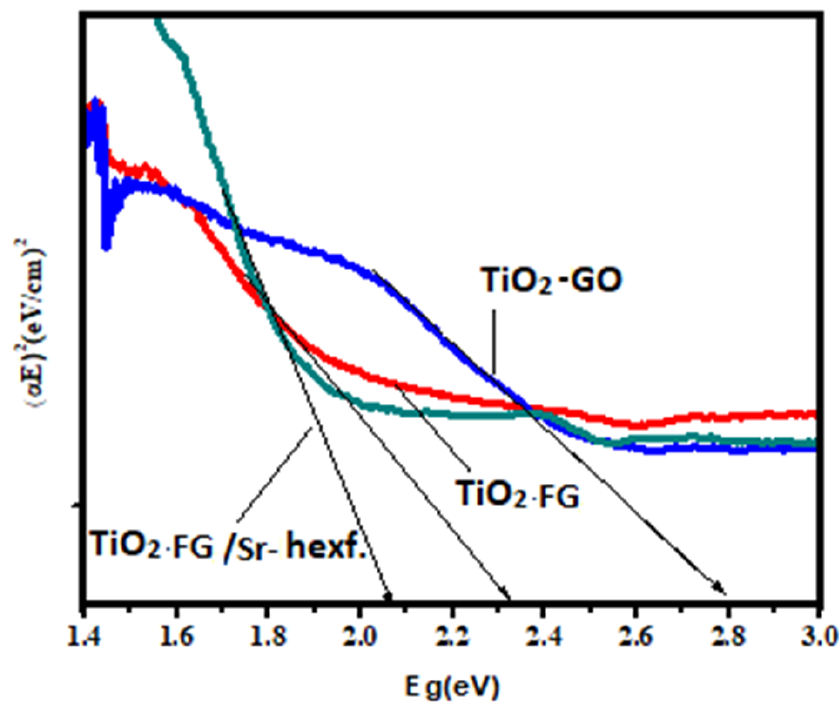
Figure 6. DRS spectra of TiO 2 ‐ GO, TiO 2 ‐ FG, and TiO 2 ‐ FG/Sr ‐ hexaferrites.